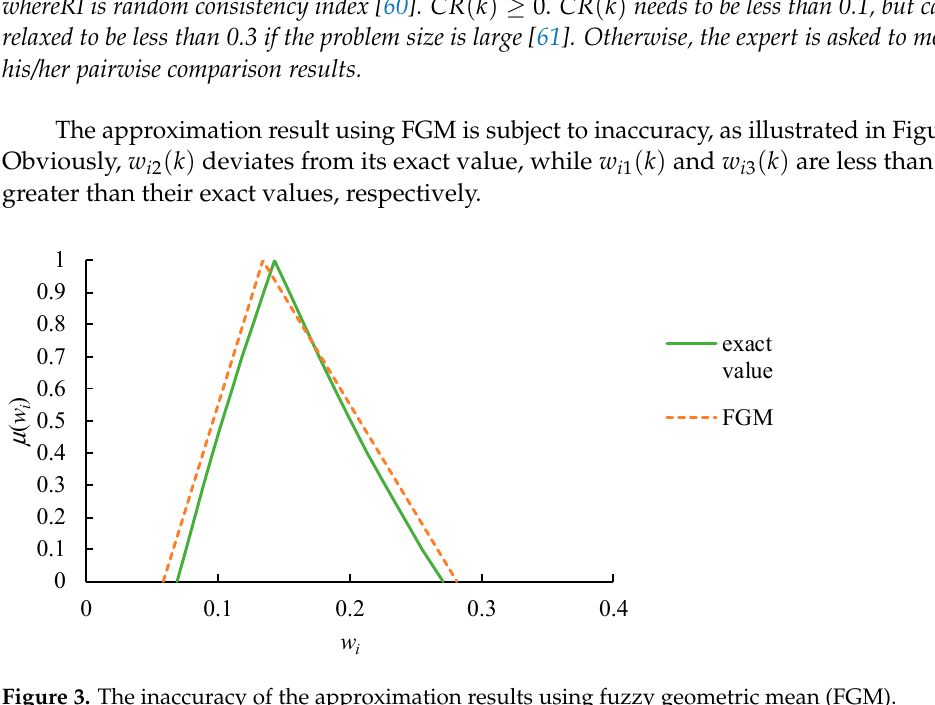
Figure 3. The inaccuracy of the approximation results using fuzzy geometric mean (FGM).